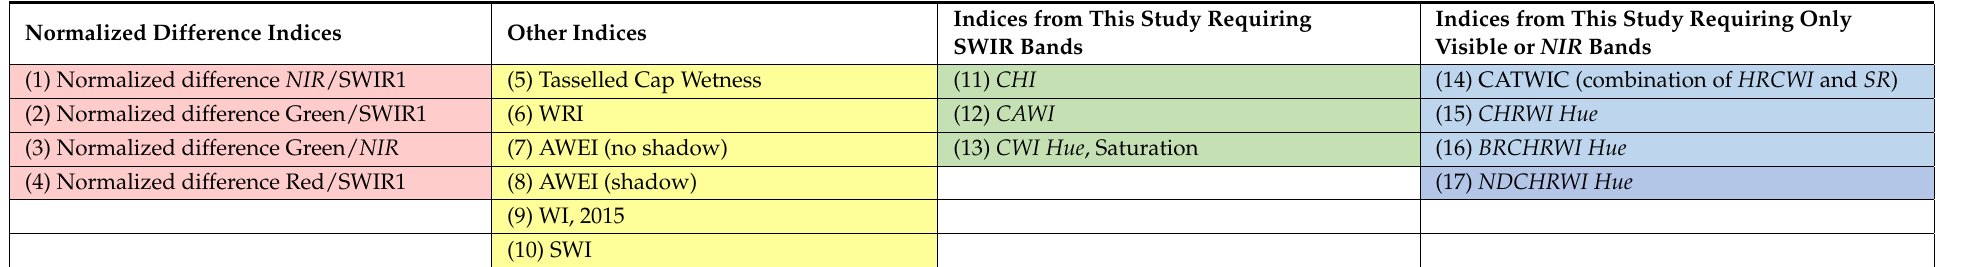
Table 3. Look-up table for the water indices compared in the decision matrix.